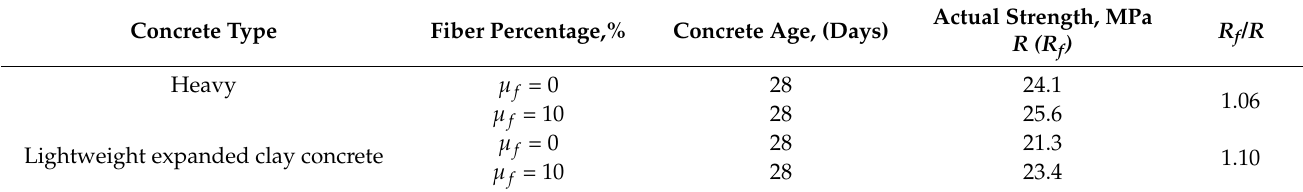
Table 6. Cubic compressive strength of fine-grained concrete